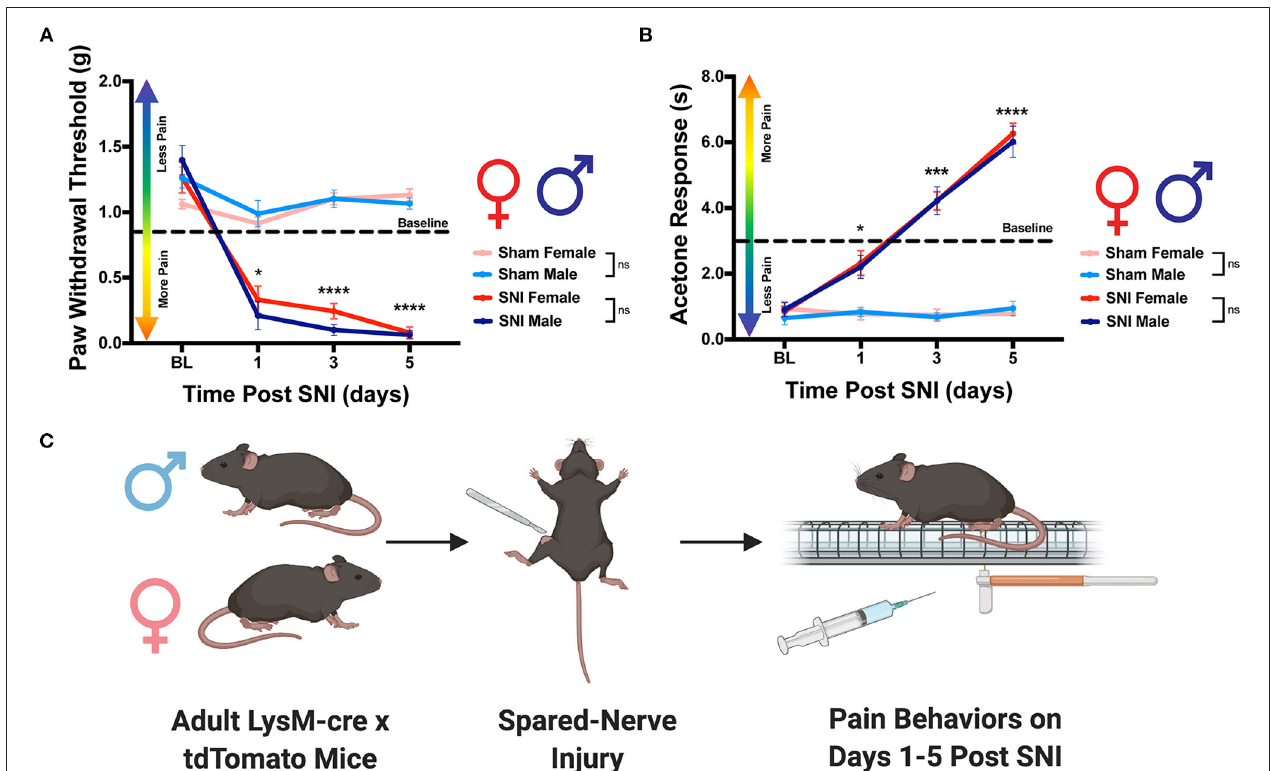
FIGURE 1 | Development of neuropathic pain behaviors following SNI. Male and female LysM tdT + mice were tested for mechanical hypersensitivity and cold allodynia on days 1, 3, and 5 post-SNI. (A) Male ( n = 7) and Female ( n = 7) LysM tdT + mice exhibit significantly reduced mechanical withdrawal thresholds post-SNI as compared to their respective sham controls ( n = 7). (B) Male ( n = 7) and Female ( n = 7) LysM tdT + mice exhibit significantly elevated response latency to acetone application as compared to their respective sham controls ( n = 7). (C) Graphical representation of the experimental timeline where male ( n = 7) and Female ( n = 7) LysM tdT + mice were given SNI and were assessed for mechanical hypersensitivity and cold allodynia on days 1, 3, and 5 post-SNI. * p < 0.05; *** p < 0.001; **** p < 0.0001. BL, Baseline. Made using